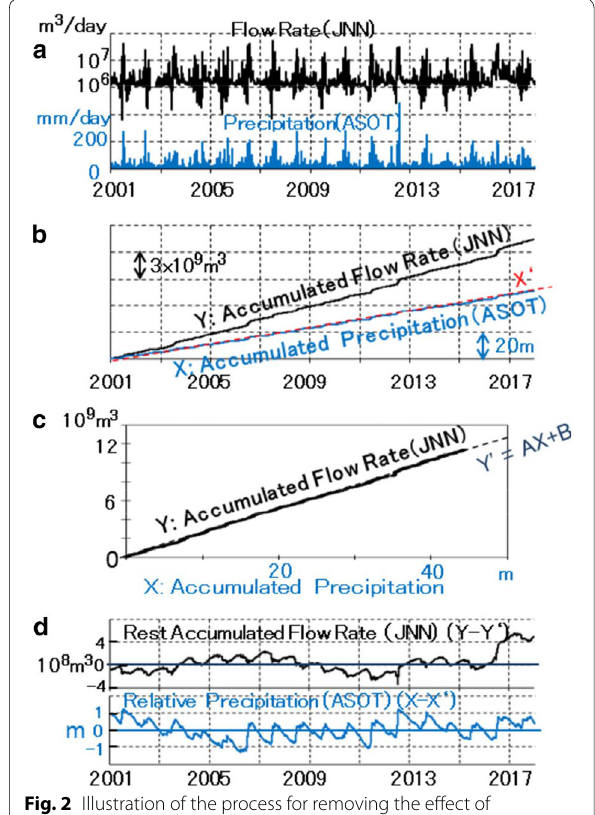
Fig. 2 Illustration of the process for removing the effect of precipitation on streamflow. a Temporal change in streamflow rate (logarithmic scale) at JNN and precipitation at ASOT. b Temporal change in accumulated streamflow rate and accumulated precipitation. Red broken line indicates average accumulated precipitation. c Correlation between accumulated streamflow rate and accumulated precipitation. d Temporal change in the rest accumulated streamflow rate and relative